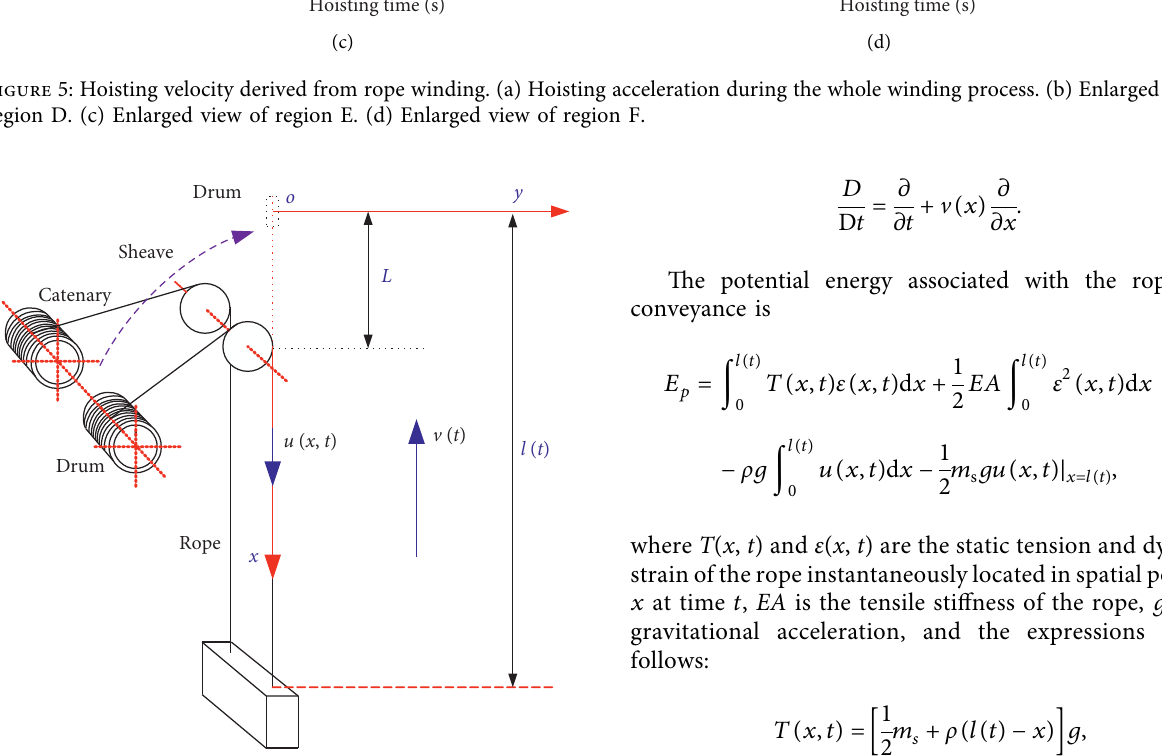
Figure 6: Modeling of longitudinal vibration of hoisting